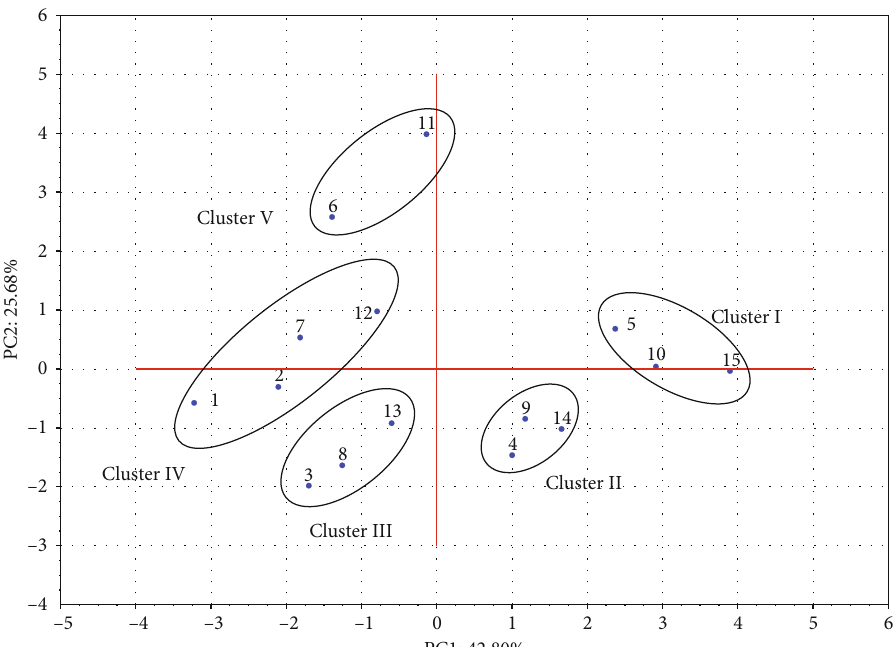
Figure 4: Score plot of PC1 vs. PC2 of the untreated, HHP-treated, and pasteurized (LPT and HPT) tomato juices during 0, 7, and 14 days of storage. Samples were coded as follows: untreated: 1, 6, and 11; 400 MPa/15 min: 2, 7, and 12; 600 MPa/15 min: 3, 8, and 13; LPT: 4, 9, and 14; and HPT: 5, 10, and 15. Numbers 1, 2, 3, 4, and 5 were assigned to the fresh samples, and the stored samples were coded as 6, 7, 8, 9, and 10 (7 days of storage) and 11, 12, 13, 14, and 15 (14 days of